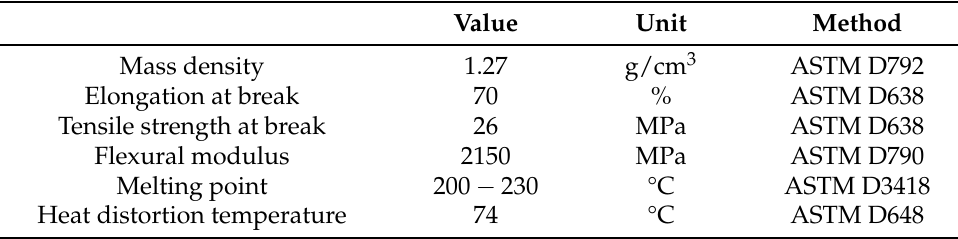
Table 3. Material properties of